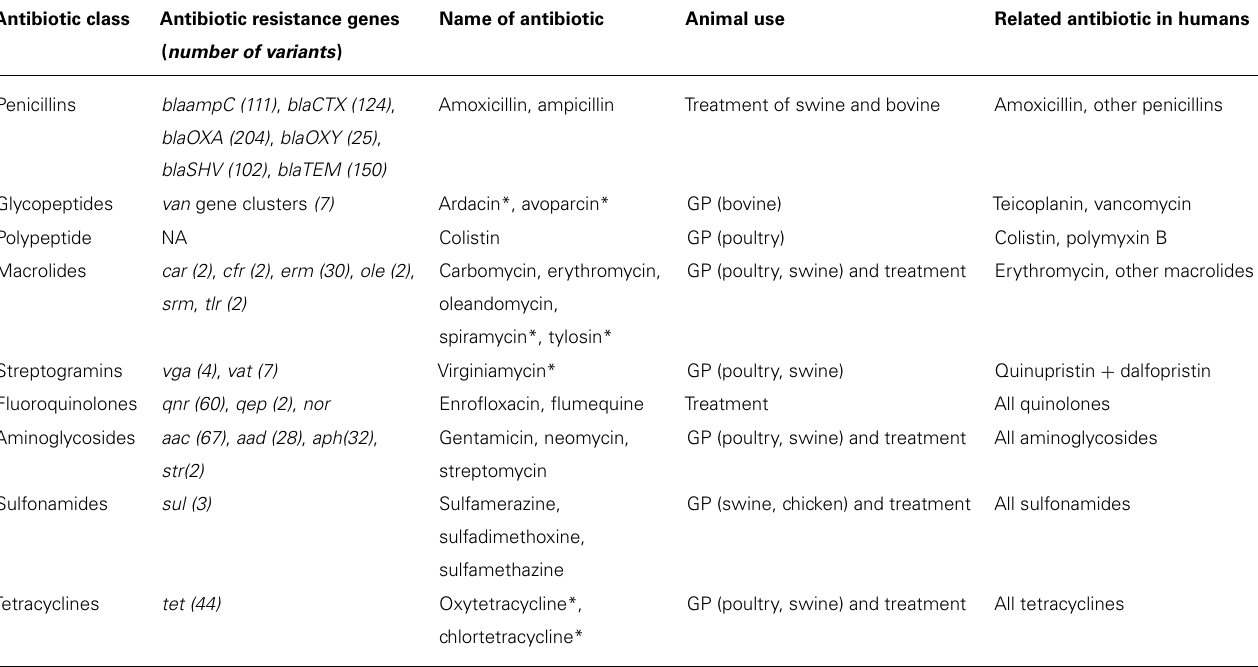
Table 1 |Antibiotics used in food animal production, antibiotic resistance genes families, and related antibiotics used in humans. Antibiotic